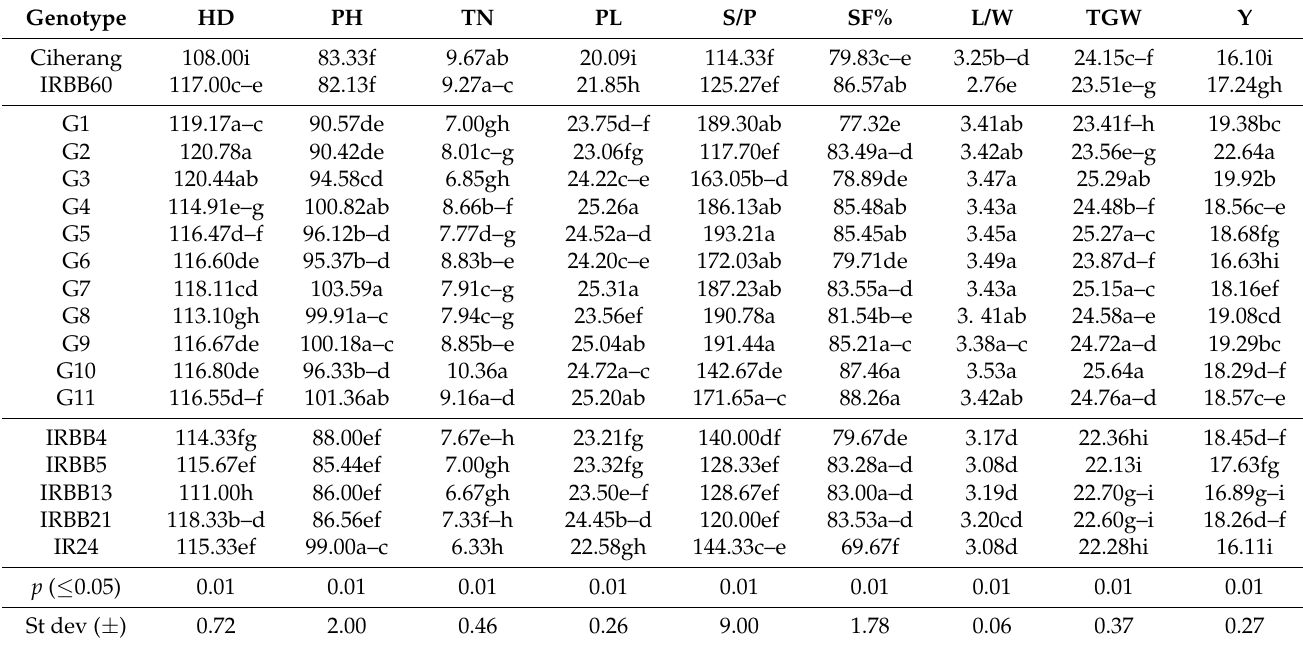
Table 4. Agronomic performance of the 85 BB resistance RILs relative to their donor and recipient parents, data represent average of 3 replications and number of RILs in a particular